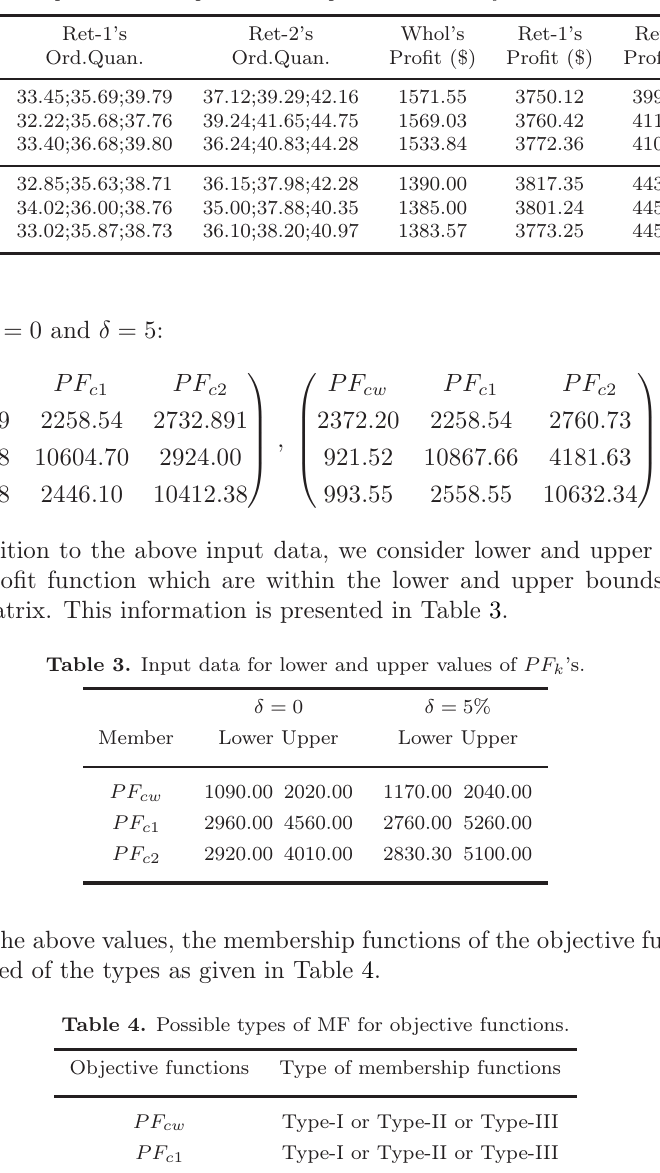
Table 2. Optimum order quantities and profits obtained by Proc 1 via MOGA.